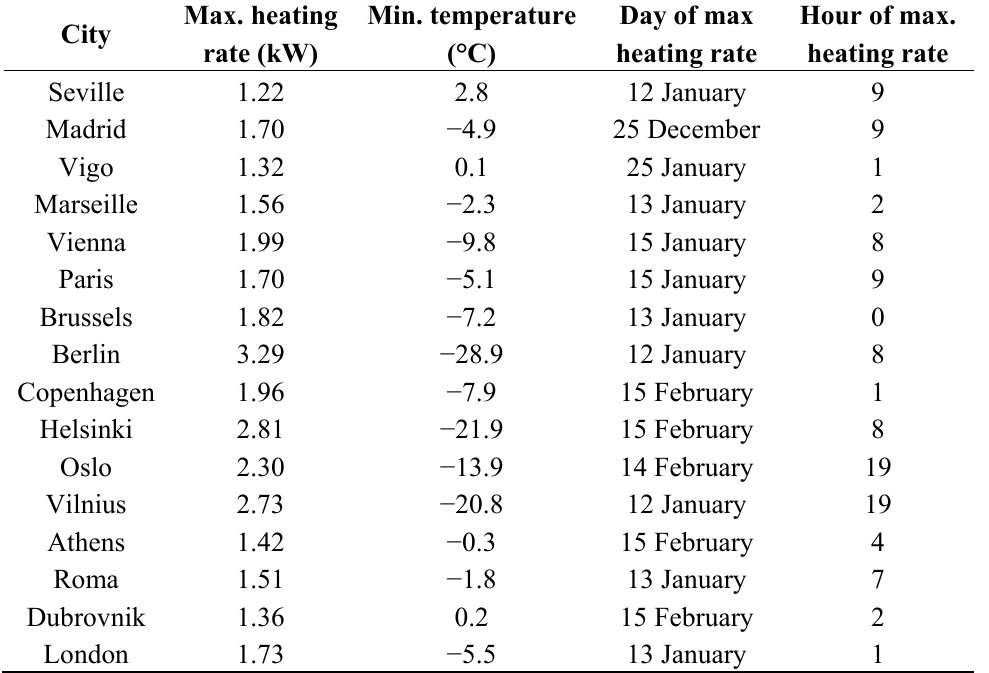
Table 5. Maximum heating rate, ambient temperature and date at the moment of maximum heating rate. Max. heating Min. temperature Day of max Hour of max. City rate (kW) (°C) heating rate